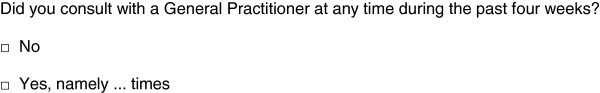
Example of an item on medical resource use.